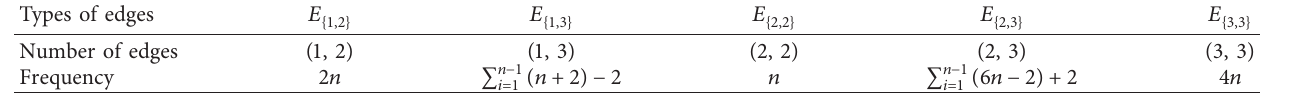
Table 5: Edge partition based on the degree of vertices.